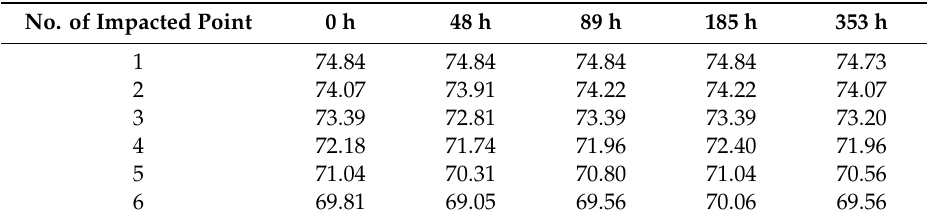
Table 1. Impact speed (m/s).